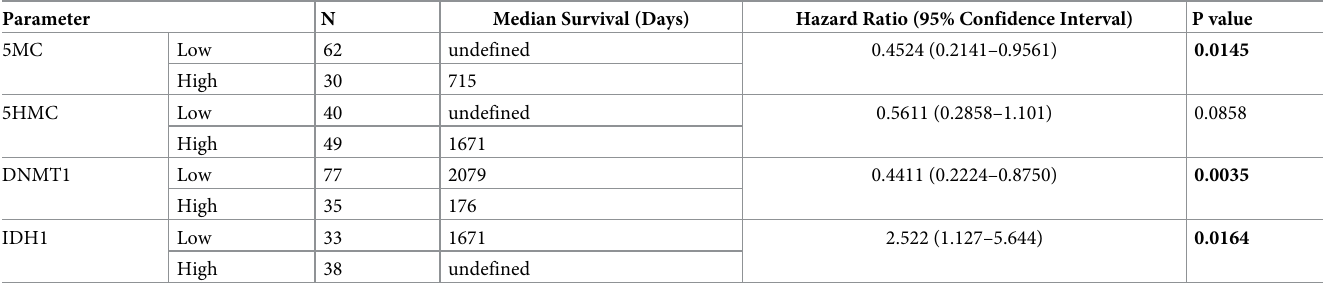
Table 1. Logrank analysis of disease free interval for all cases.